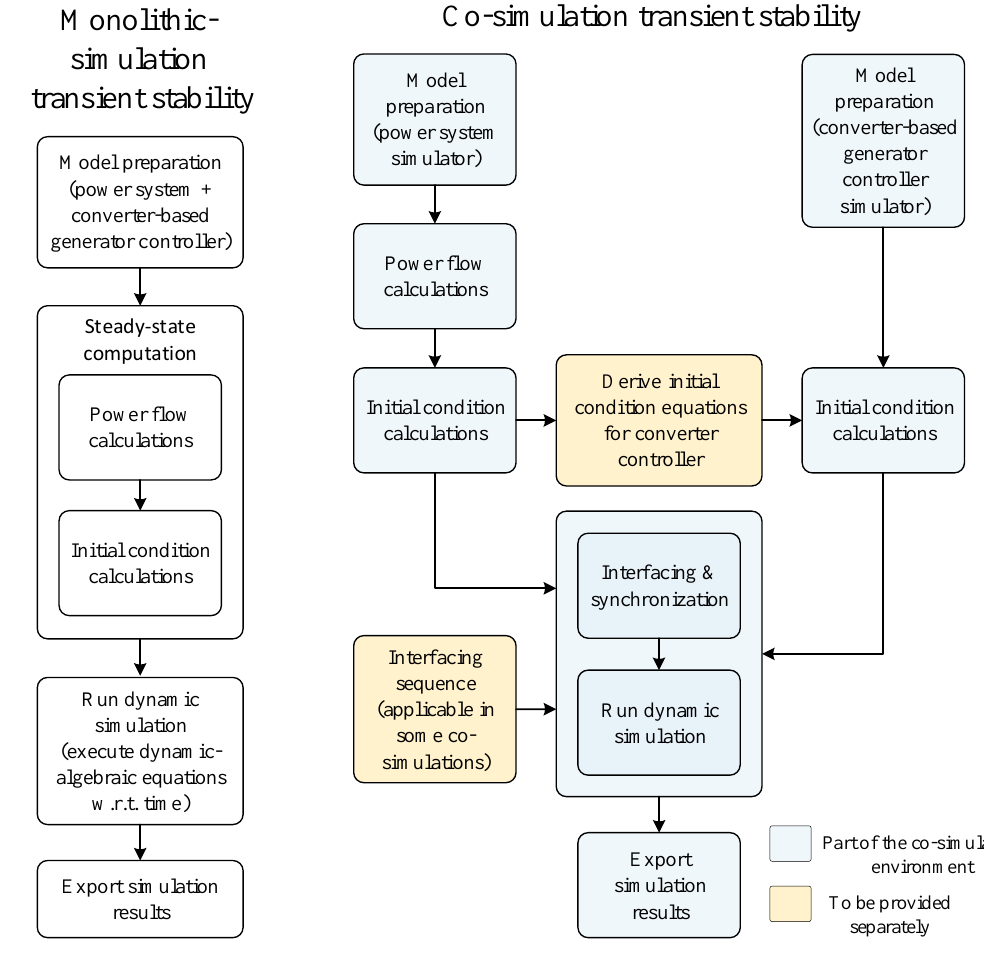
Figure 1. The monolithic ( left ) and co-simulation ( right ) transient stability simulation